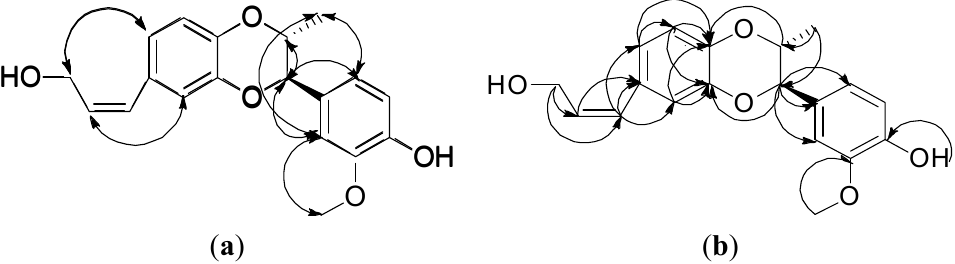
Figure 2. Key NOESY ( ↔ ) ( a ) correlations and HMBC connectivities ( → ) ( b ) of compound 1